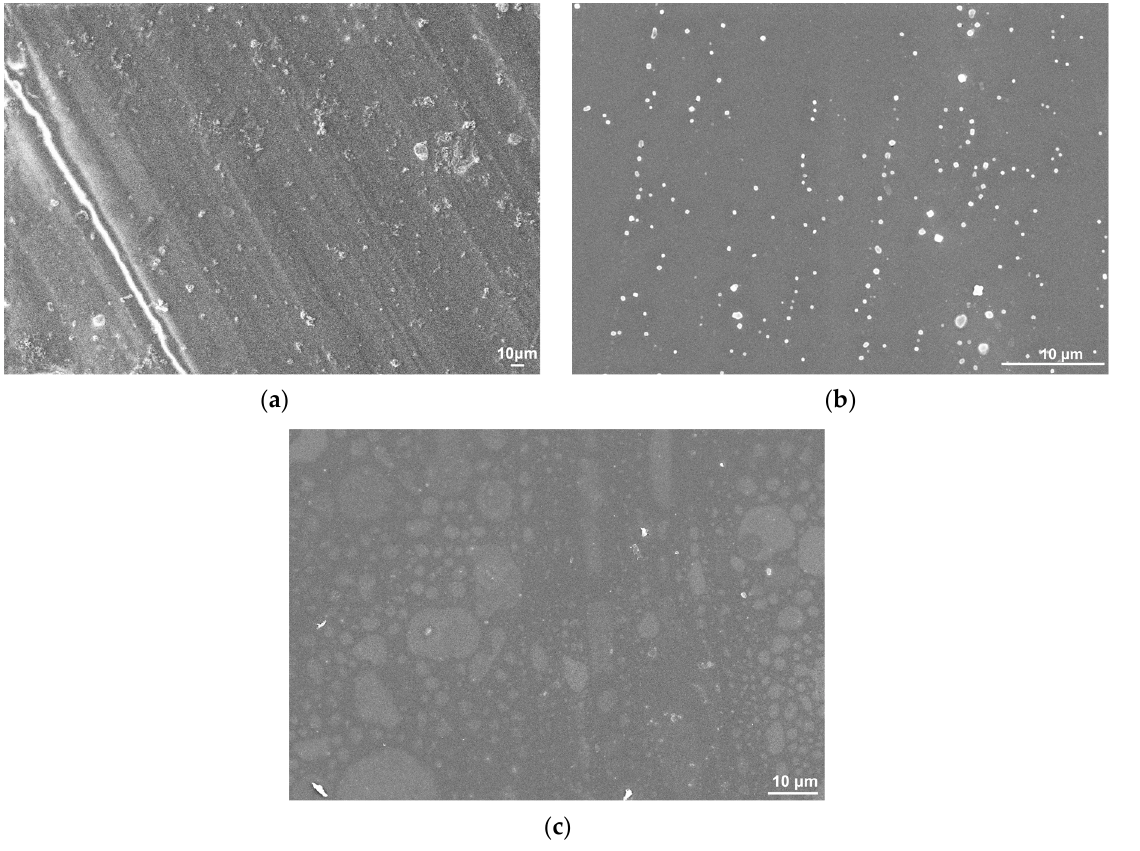
Figure 1. SEM micrographs for blank Al substrates ( a ) and modified Al plates with PVA ( b ) and TEA ( c ), respectively, via the MAPLE technique; scale bar: 10 μ m.